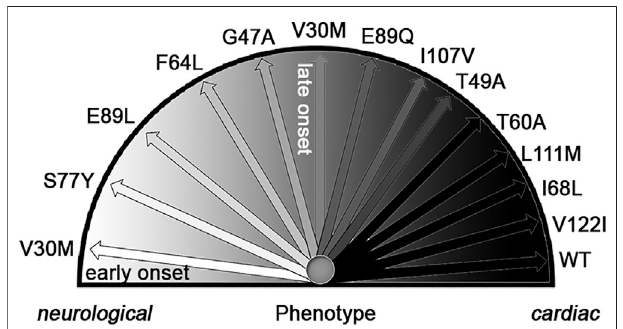
FIGURE 4 | Genotype-phenotype correlation in ATTR amyloidosis. Adapted from Figure2 inaprevious publicationbyRapezzi andcollaborators (Rapezzi et al., 2013). Phenotypic expression of transthyretin-related amyloidosis varies widely from an almost exclusively neurological involvement (V30M mutation with early-onset disease) to a predominant or exclusively cardiac involvement (T60A, L111M, I68L, and V22I mutations and wildtype). Inbetween, several transthyretin-related amyloidosismutations are associated with variable degrees of neurological and cardiac involvement, including V30M with late-onset disease. Adapted with permission by Oxford University Press, Copyright